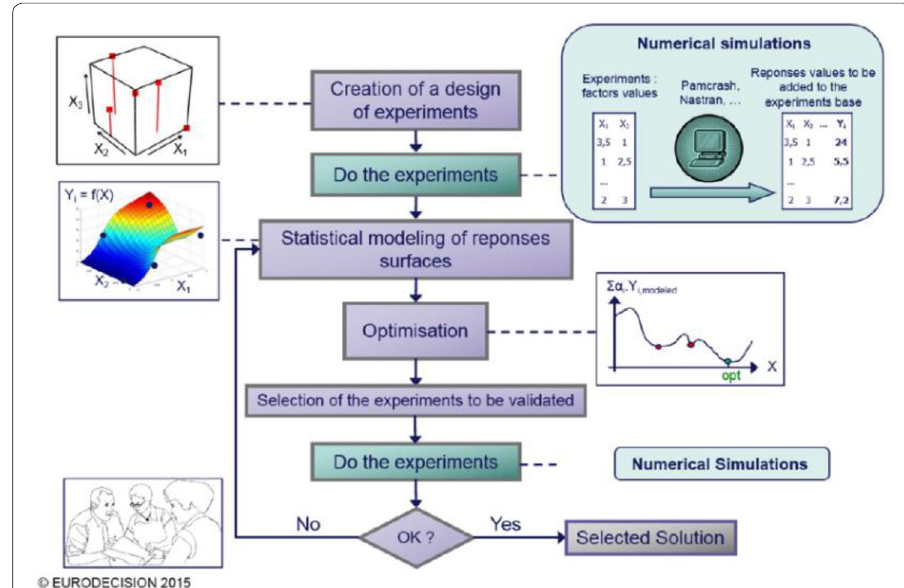
Fig. 1 Optimization process at Renault